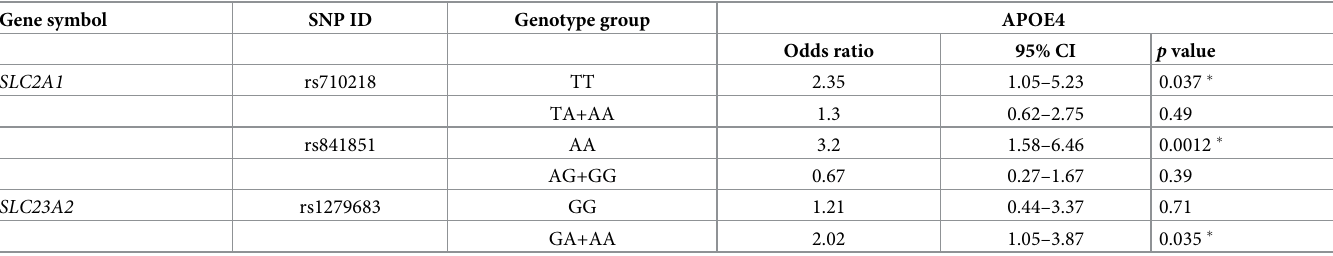
Odds ratio of APOE4 was calculated by multivariate logistic regression analysis, adjusted for effects of baseline age, follow-up period, baseline MMSE points, and sex. � p < 0.05.